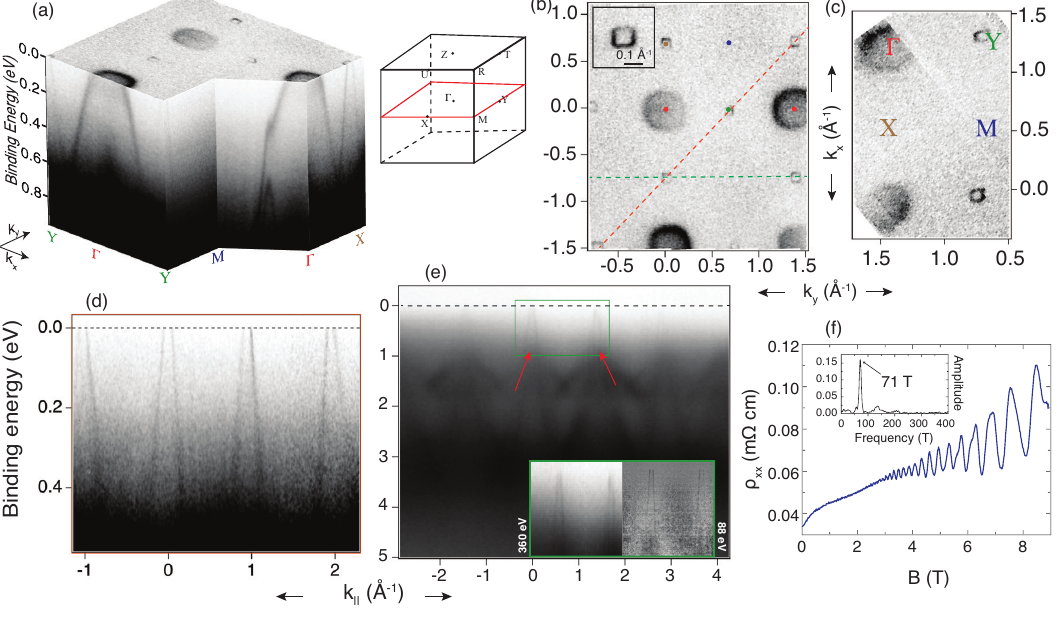
Figure 2: ARPES data overview. (a) ARPES data block (I05, h ν = 88 eV, circular right polarisa- tion, T = 10 K) showing the electronic structure of SrMnSb vs. the in-plane momentum, k . x , y 2 High symmetry points for the surface projected Brillouin zone are labelled, and a schematic of the bulk and surface-projected Brillouin zones is included. The top surface displays the Fermi surface of the system, which is shown in a plan-view in panel (b), including a zoom of the small Fermi surface, recorded using 27 eV photons. The contour of the Fermi surface centred = 0, k = -0.7 Å − 1 ) is a rounded square, with an area of only 0.3% of the 2D at the Y-point ( k x y Brillouin zone. Panel (c) shows a Fermi surface map recorded at BESSY-II (h ν = 95 eV, circular right polarisation, T = 1 K) in which only a single twin domain of the sample is picked up in the measurement, showing clearly the small FS’s are now only centred on the Y-points. Panel (d) shows a cut taken along the orange dashed line in panel (b), which dissects four of the small Fermi surfaces, highlighting their very straight dispersion relation. Panel (e) contains a different cut through k -space, showing a line through either X or Y-points alternating with M-points, measured using soft X-rays (I09, h ν = 360 eV, linear horizontal). The inset superim- poses an analogous cut measured using 88 eV photons, as in panels (a), (b) and (d), showing that relaxing the extreme surface sensitivity of the VUV excitation does not alter the electronic structure. Panel (f) shows the very clear quantum oscillations observed in the resistivity (SdH) from crystals from the same growth batch. The Fourier transform in the inset shows a funda- mental frequency of 71 T, which would correspond to a Fermi surface area of 0.33% of the 2D Brillouin zone, in excellent agreement with the ARPES data for the Y-centred Fermi